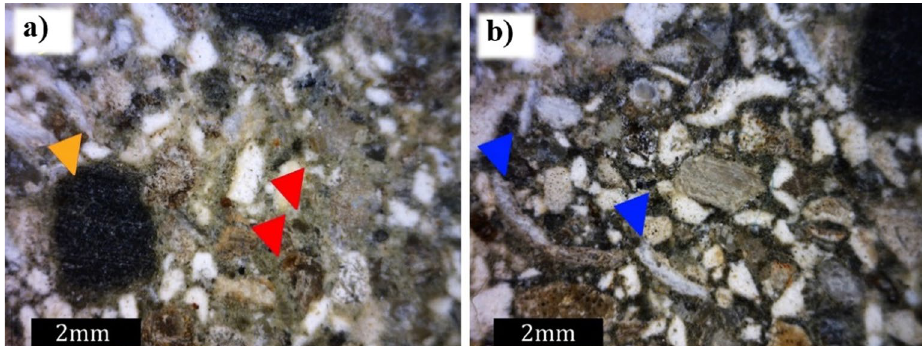
Figure 10. General aspects observed in the Dino-Lite Pro Lupa. ( a ) Faceted quartz grains (red arrow) and round grains related to potential minerals of the oxide group (rutile, ilmenite, and magnetite—orange arrow) and ( b ) carbonatic skeletal grains interpreted as bivalve carapaces (blue arrow).